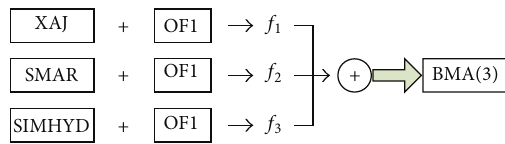
Figure 2: Diagram of BMA(3) combination scheme.